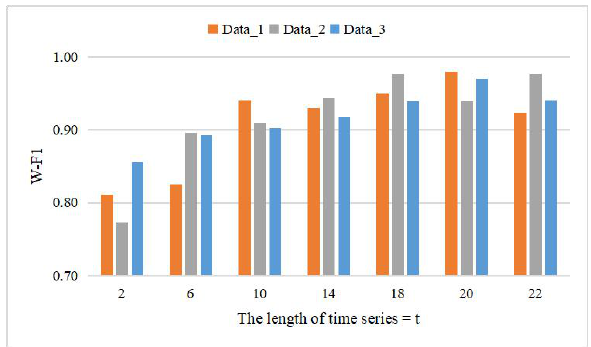
Figure 9. The results of comparative experiments with various temporal length.